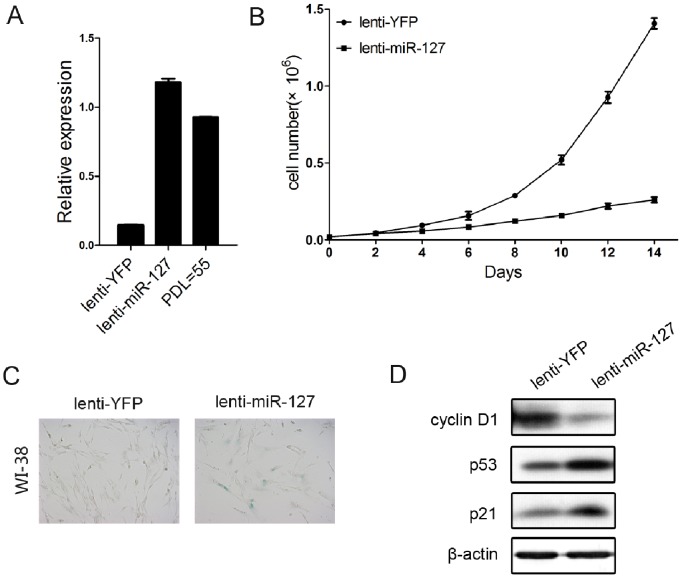
Stable expression miR-127 affects senescence phenotypes in WI-38 fibroblasts.(A) Stable expression of miR-127 in WI-38 cells infected by lentiviral constructs and endogenous expression of miR-127 in senescent WI-38 cells were evaluated by qRT-PCR analysis. Data are presented as the mean ± SD from three independent experiments. (B) Growth curves of WI-38 cells stably infected with pLenti6/V5-D-premiR-127 or pLenti6/V5-D-YFP. Cells were counted every two days for two weeks. Data are presented as the mean ± SD from three independent experiments. (C) SA-β-gal staining of senescent cells induced by stable overexpression of miR-127. The WI-38 cells were stained for SA-β-gal activity 10 days after lentiviral infection. (D) Western blot analysis of senescence-associated proteins in WI-38 cells 6 days after lentiviral infection. β-actin was used for normalization.